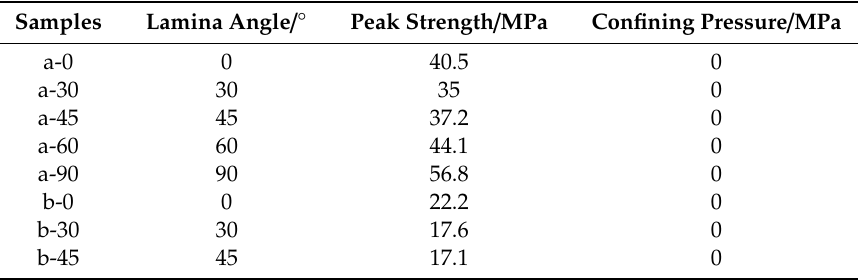
Table 3. Peak strength values of the stress–strain curves in Figures 2 and